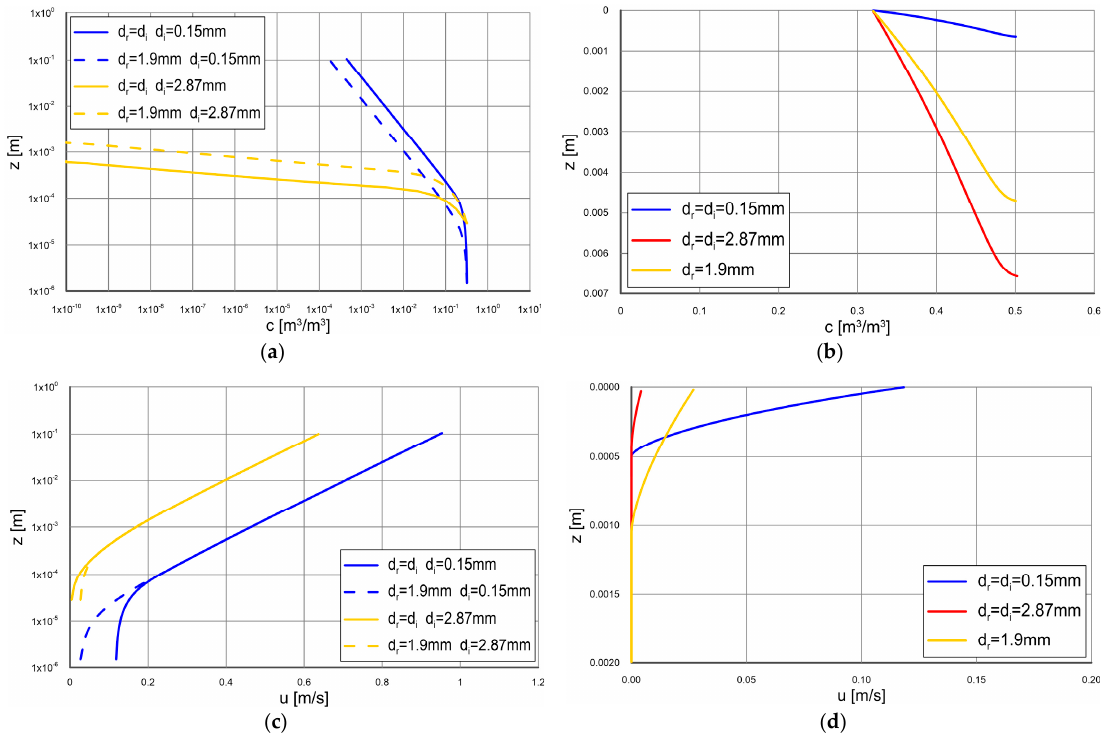
Figure 10. Calculation results ( u (cid:48) f ∗ = 0.042m/s ) of concentration in vertical profiles for heteroge- neous sediments with the representative diameter d r in: ( a ) the contact layer, ( b ) grain collision sublayer and of velocity vertical profile in: ( c ) the contact layer; ( d ) grain collision sublayer.